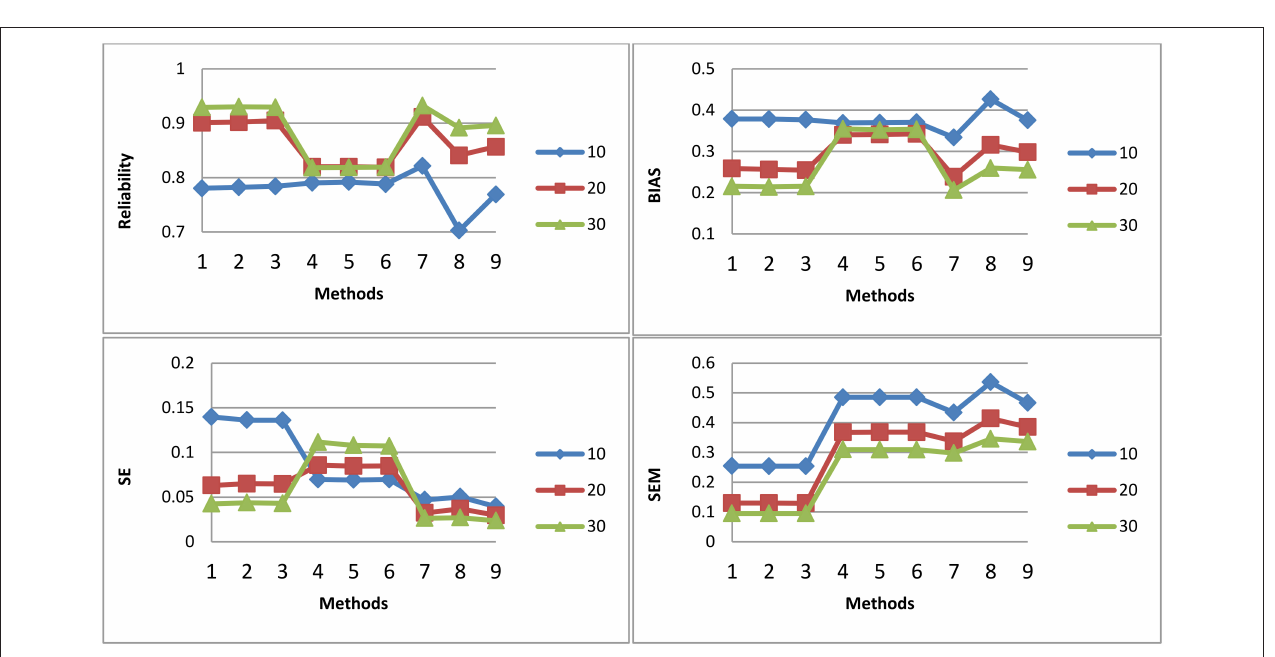
FIGURE 2 | Reliability, BIAS, empirical SE, and SEM for test length of 10, 20, and 30 for all 9 procedures for selection method